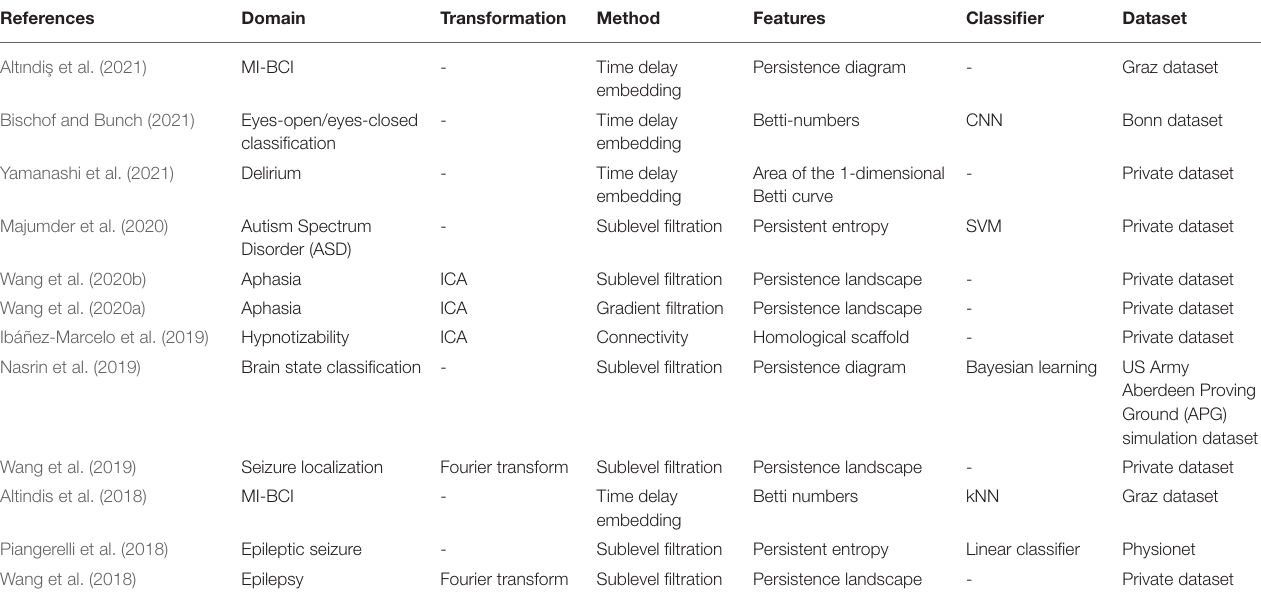
TABLE 1 | Summary of applications of TDA to EEG analysis (ordered by publication